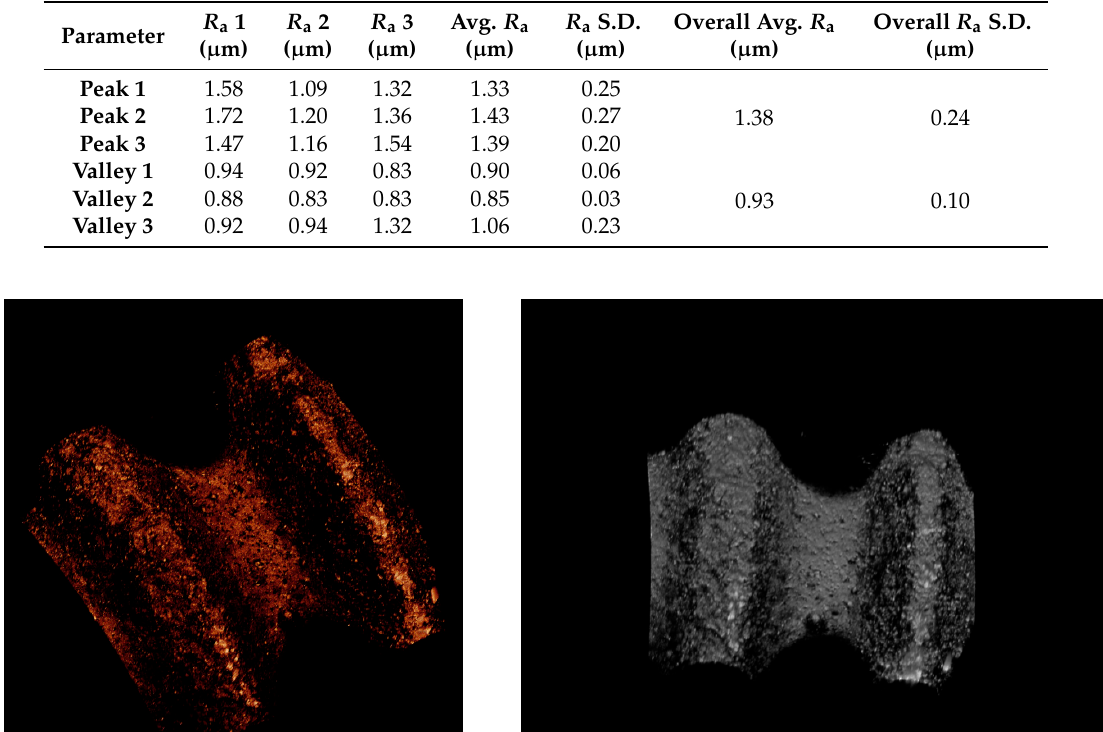
( b ) Figure 5. Transversal cross-sections of different nanocomposite ZCe-A implant-bone interfaces after eight weeks of healing. ( a ) and ( b ) show two different interfaces In general, we can clearly appreciate bone growth in direct contact with the surface of the implant. There are some areas that present a small gap of less than 5 µm, which can be due to an artefact of the histological process (see arrow in Figure 5a). There is no connective tissue interposed between the surface of the implant and the bone. There are no signs of inflammation at the interface or of adjacent bone. The bone that is in contact with the implant shows, in some areas, very few characteristics of immature bone and a typical woven bone cell distribution (plexiform) (Figure 5b), although it mostly consists of laminar and haversian bone. There are no images of bone sequestration, nor atypia or dysplasia. Figures 6 and 7 show longitudinal sections of the implant-bone interface.